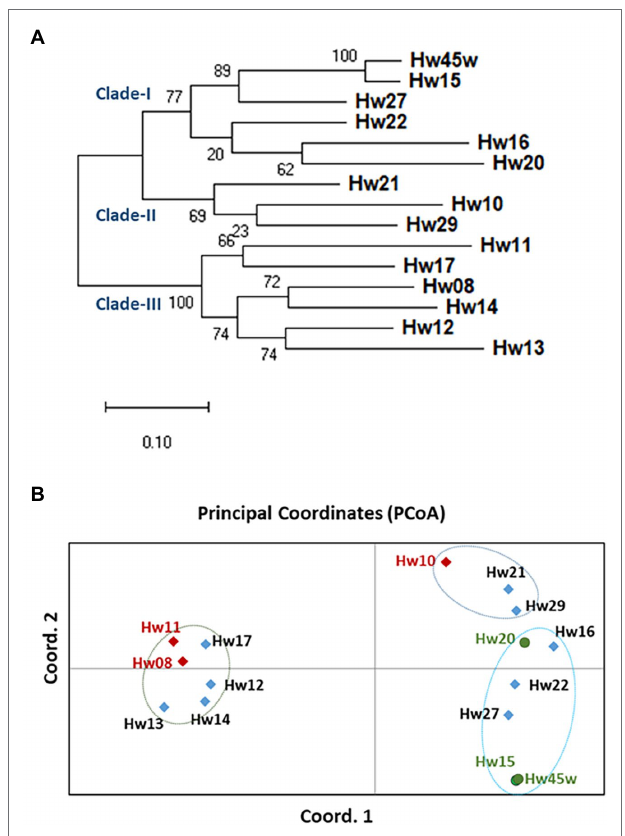
FIGURE 5 | Genetic divergence and evolutionary relationships among western hemlock individuals. (A) The phylogenetic tree constructed using maximum likelihood (ML) method. A total of 1,043 ns-SNPs extracted within 599 defense- and resistance-related genes were included for alignment of polymorphic loci. The bootstrap values determined with 100 repeats are represented close the branching nodes. (B) Principal Coordinates Analysis (PCoA) of western hemlock samples based on ns-SNPs data (variance of axis 1: 39.95%; variance of axis 2: